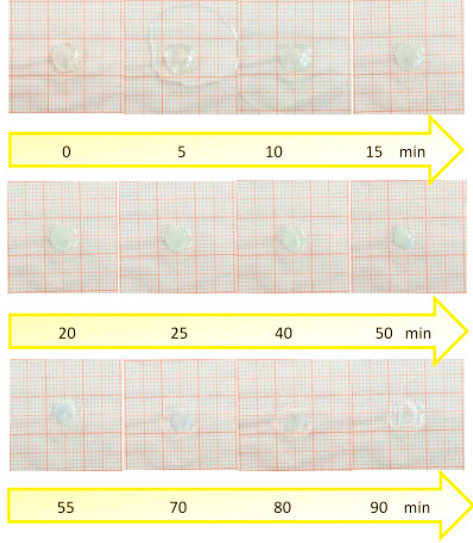
Figure 4. Timeline from 0 to 90 min of the radial swelling of the patch.